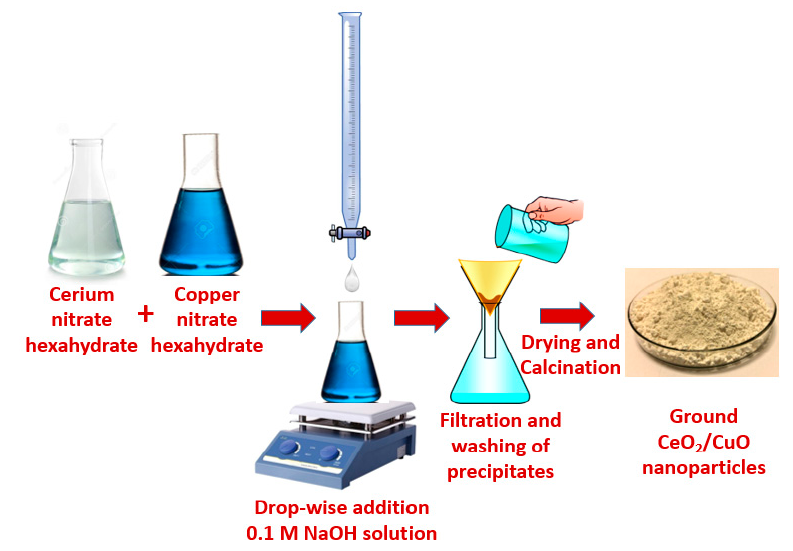
Figure 1. Synthesis scheme of CeO 2 /CuO